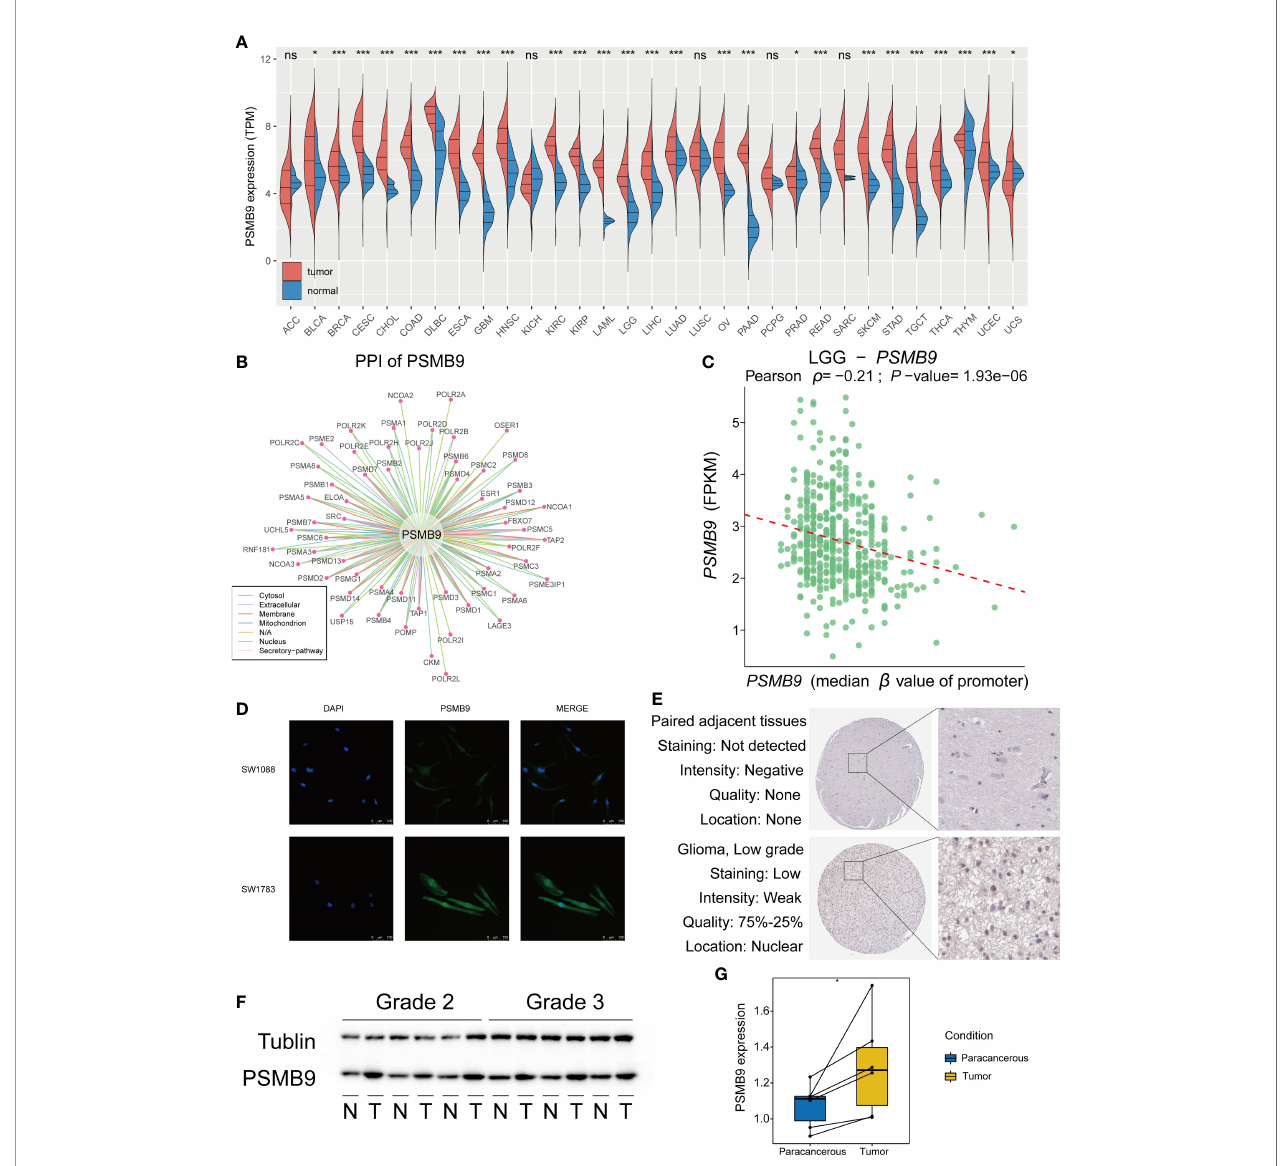
FIGURE 2 | Overview of PSMB9 protein in tumor samples. Basic expression, characteristics and distribution of PSMB9. (A) PSMB9 protein is differentially expressed in most tumors and is usually highly expressed in tumor tissues. (B) The PPI network of PSMB9. (Data derived from Pubmed). (C) The relationship between the level of promoter methylation and PSMB9 expression shows a higher PSMB9 expression correlated with a lower promoter methylation level. (D) Confocal images verify the distribution of PSMB9 in SW-1088 and SW-1783 cells and indicate that PSMB9 protein was expressed in both nucleus and cytoplasm. (E) The difference of PSMB9 protein expression and location between normal and tumor tissues were detected by immunohistochemistry which suggested that the expression level of PSMB9 was signi fi cantly increased in tumor tissues (Images were downloaded from Human Protein Altas). (F) WB veri fi es PSMB9 protein expression differences in clinical tissue samples. Tumor tissues have a higher PSMB9 expression than normal tissue. (G) ImageJ detects protein gray values for paired tests to determine protein expression